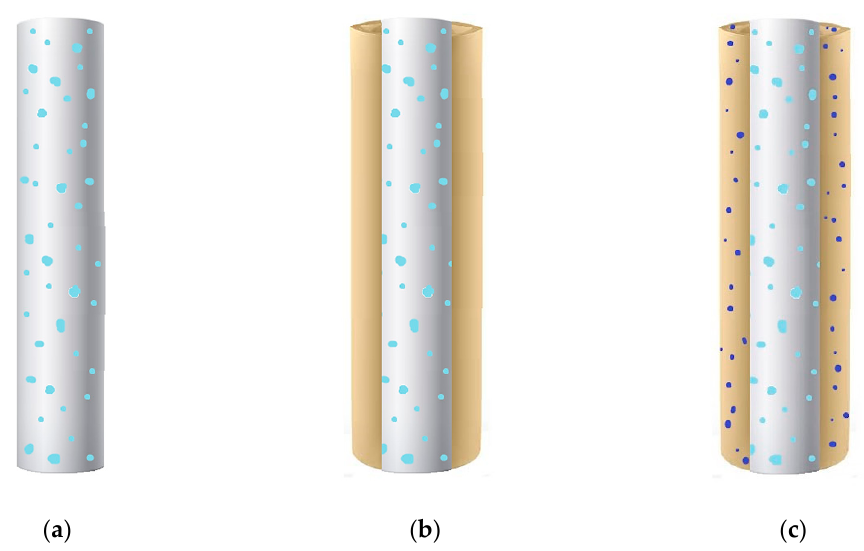
Figure 2. Possible PVP-based fibers: ( a ) active principle dispersed into the polymeric matrix; ( b ) drug dispersed into the core of a core–shell structure; and ( c ) drug dispersed both into the core and the shell of a core–shell structure. Table 2. PVP-based fibers. FBs, fibers; PLLA, poly( L -lactic acid); PCL, polycaprolactone; H- β -CD,